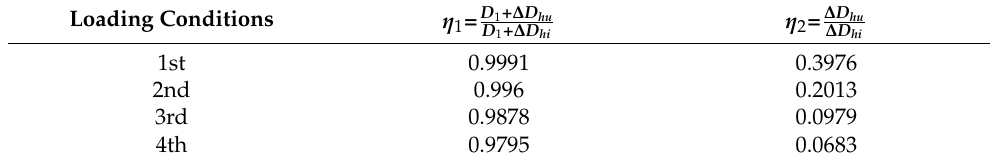
Table 5. Effective ratios of the transverse bending rigidity calculated using different